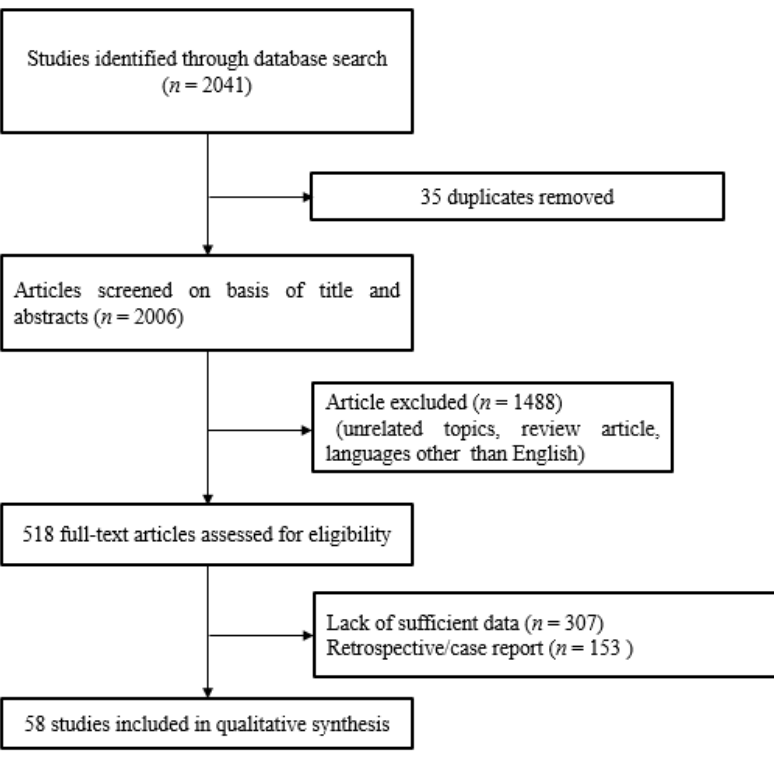
Figure 1. Flowchart of study selection according to PRISMA guidelines.